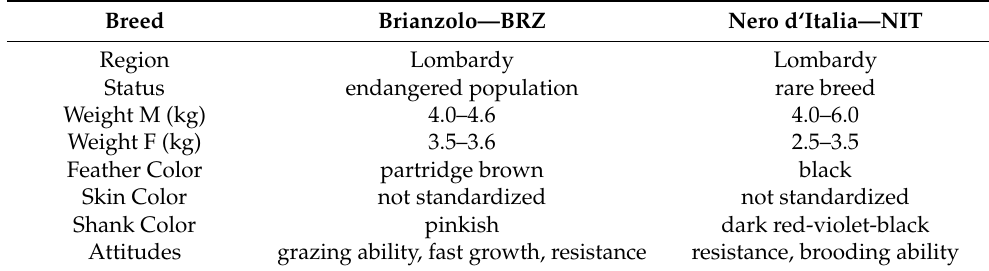
Table 1. Breed description: name, Italian region of origin, status, feather color, shank color, and attitude (FIAV standard,